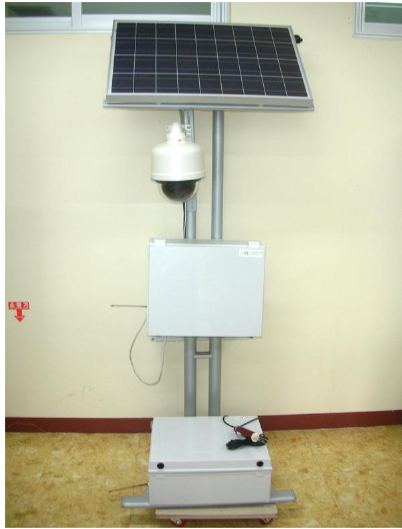
Figure 6. Prototype Version 1 of the Agricultural Environment Monitoring Server System.